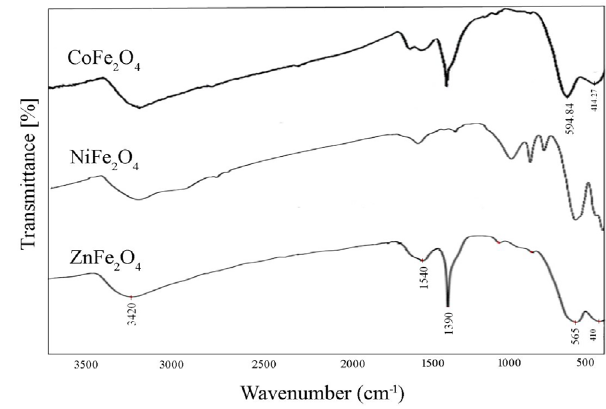
O , NiFe O , and ZnFe 2 4 2 4